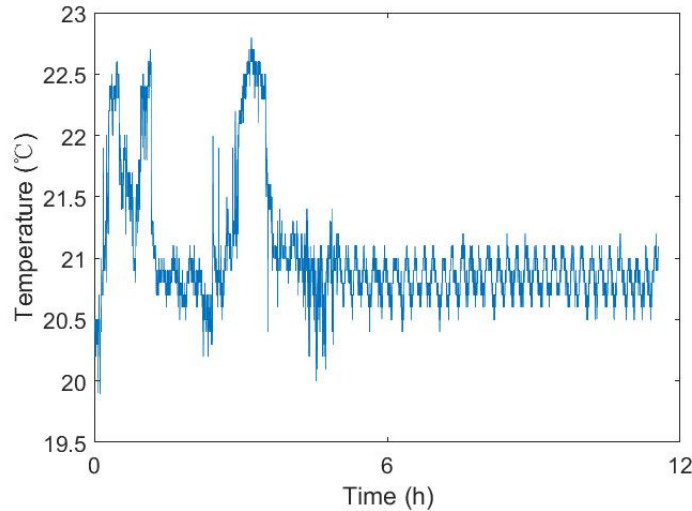
Figure 7. Results of laboratory temperature test over 12 h.